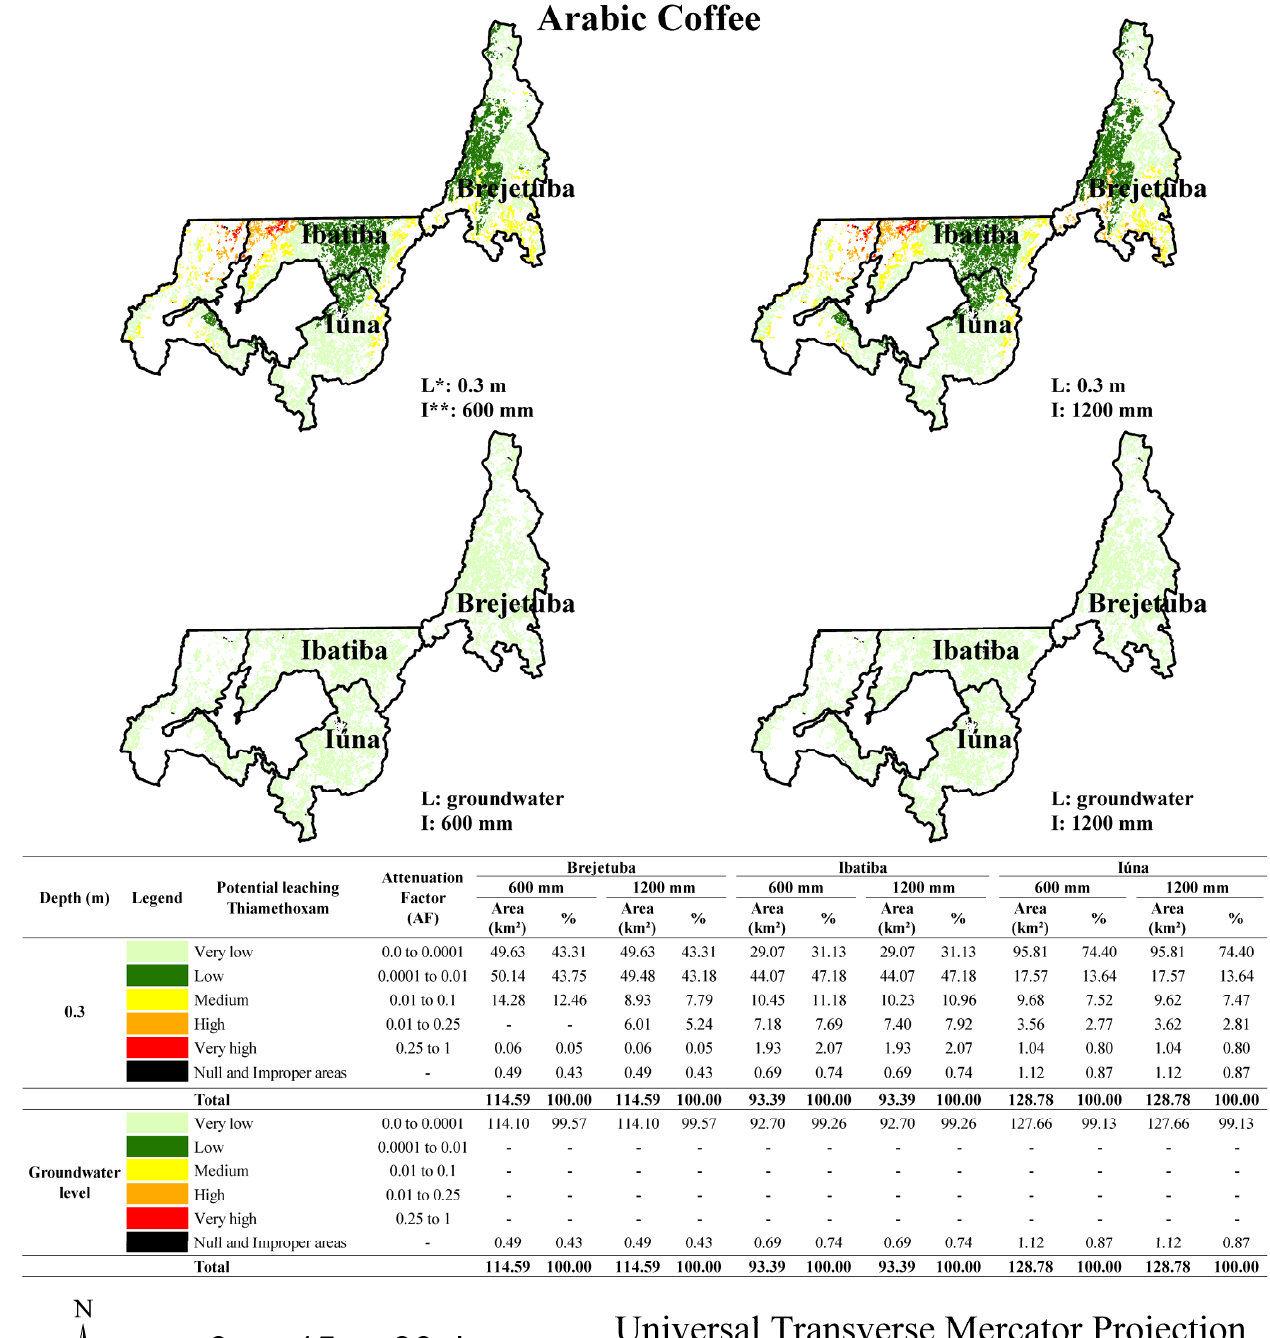
Figure 7. Attenuation Factor ( AF ) of active ingredient thiamethoxam evaluated for areas cultivated with arabica coffee ( Coffea arabica L.) for the municipalities of Brejetuba, Ibatiba and Iúna, ES, Brazil. * L: Groundwater depth and ** I: Irrigation.